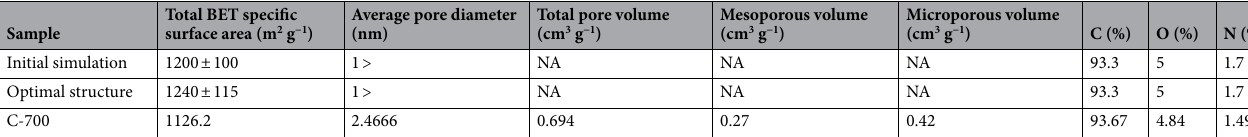
Table 3. Material characteristics of simulation and experimental